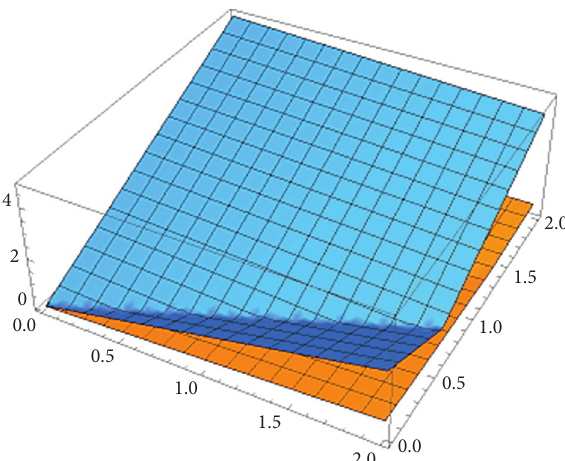
Figure 1: Dominance of right-hand side of equation (27) is visually checked for τ , υ ∈ [ 0 , 2 ] .